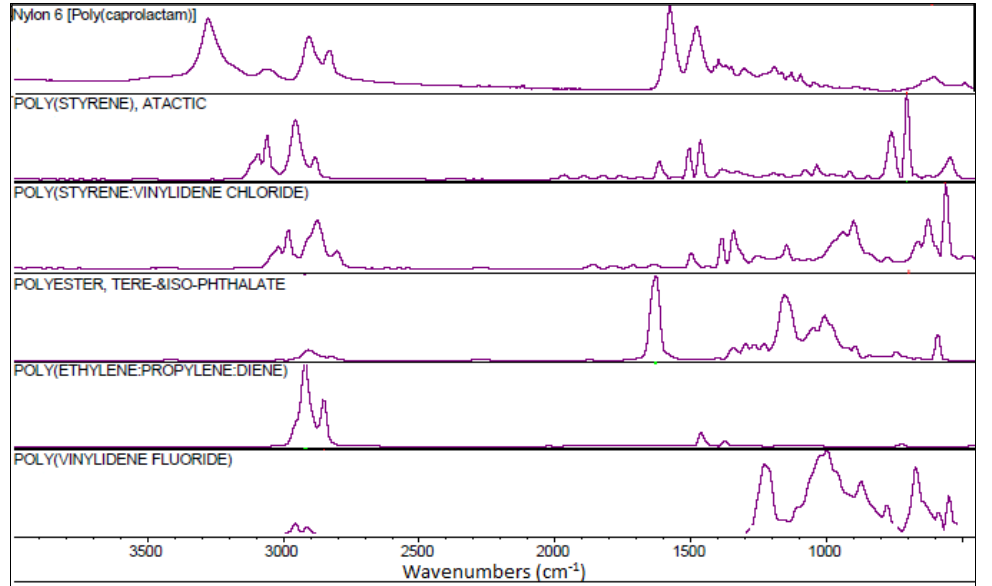
Figure 6. Most common microplastic polymers determined with ATR-FTIR in the present study.